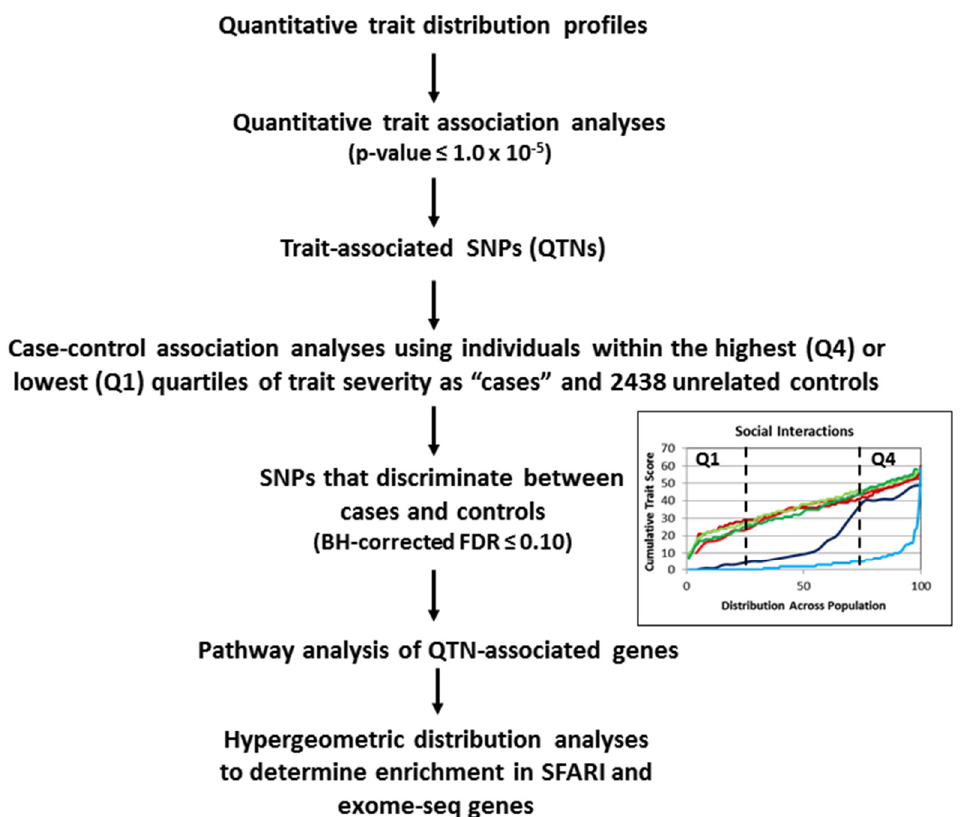
Scheme 1. Workflow for two-phase genetic analyses using both quantitative trait and case-control association analyses of individuals stratified according to severity of traits.